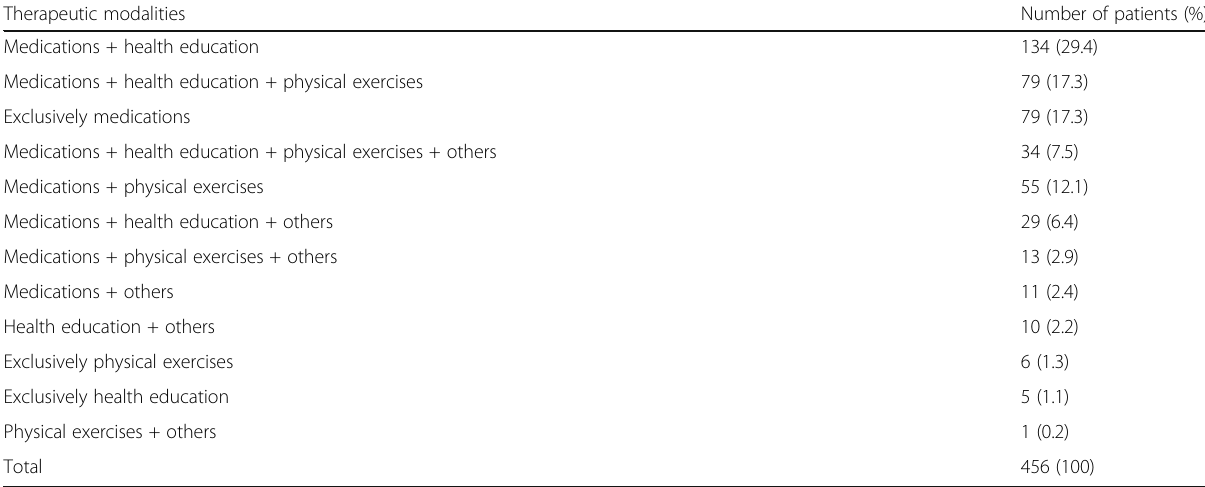
Table 1 Combination of the therapeutic modalities used by patients with fibromyalgia Therapeutic modalities